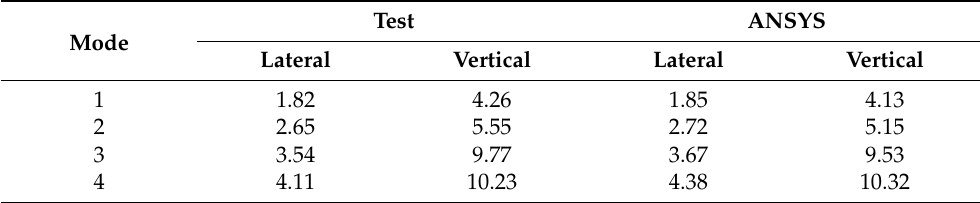
Table 1. The first four frequencies of the